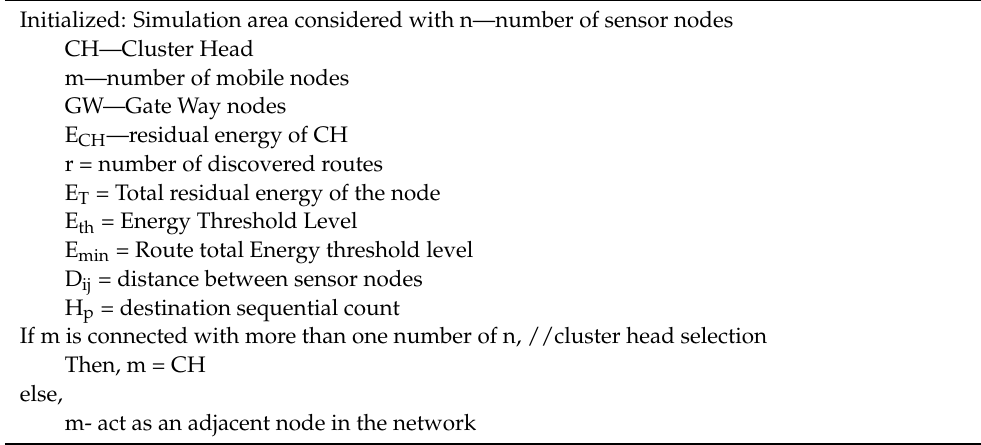
Algorithm 1: Algorithm for MANET-ESO in